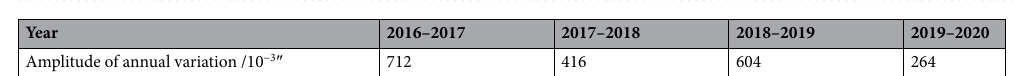
Figure 8. Plots of the vertical pendulum tilt meter recorded at the Yutian Observatory: ( a ) blue and red curves indicate N–S and E–W daily data of the vertical pendulum tilt meter, respectively. The green vertical line is the magnitude and time of the Yutian earthquake; the orange box shows the period of anomalous annual variation ( b ) annual variation of the N–S direction from January 1, 2017 to June 26, 2020; ( c ) annual variation of the E–W direction from January 1, 2017 to June 26, 2020. The turning change of NS component ( b ) in Agust 2019 was caused by the man-made transformation. The yellow dotted line ( b ) represents the previous trend movement from Agust and December. The yellow dotted line of EW component ( c ) represents the likely normal annual trend at the end of 2019. The unit of the horizontal axis is time, and the ‘T/a’ and ‘T/m’ means ‘time/year’ and ‘time/month’ respectively.